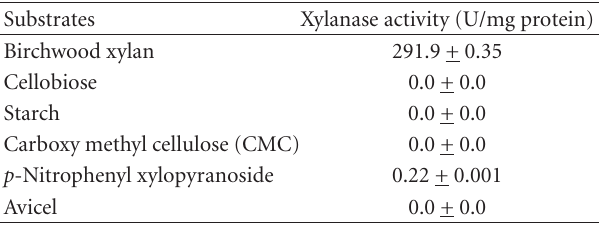
Table 3: Substrate specificity of purified